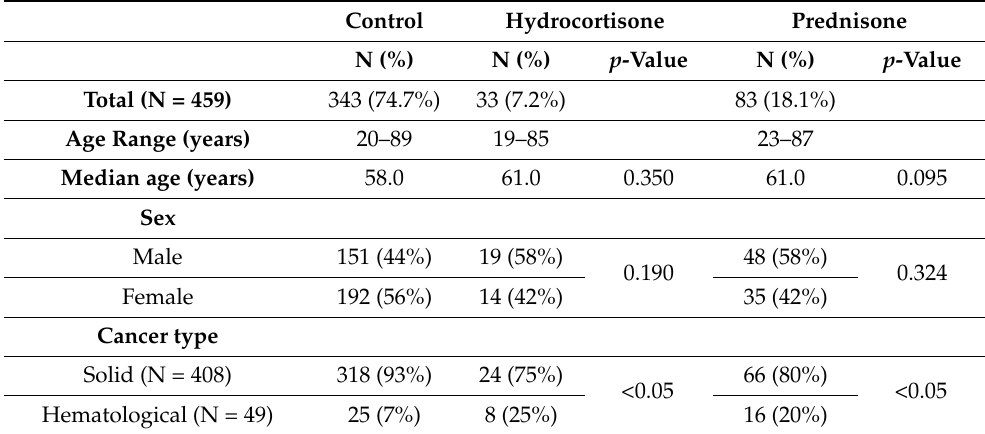
Table 1. Sample characteristics according to treatment